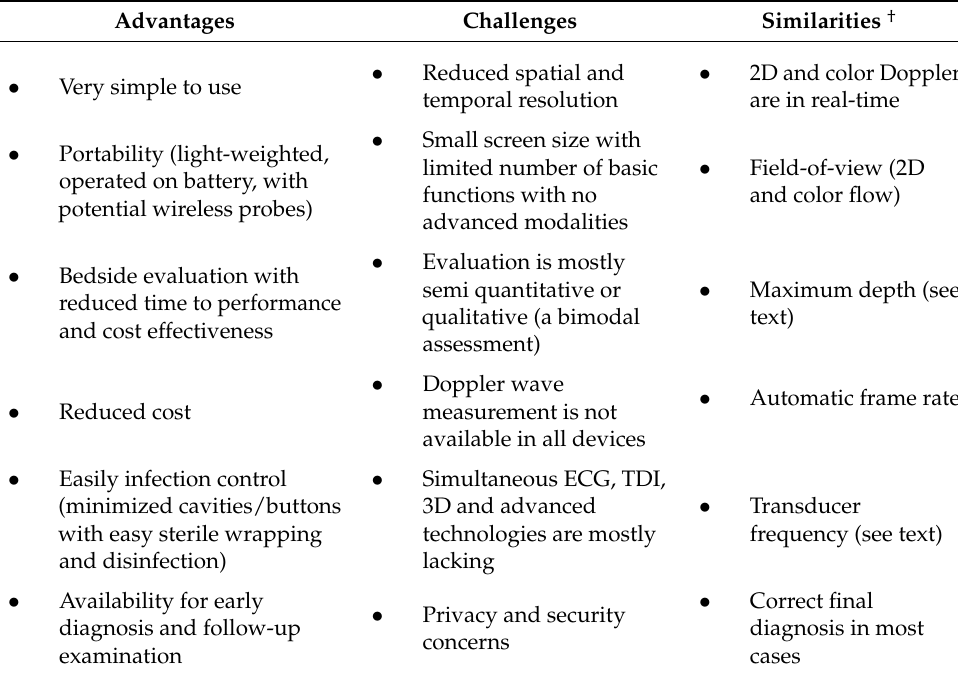
Table 1. Advantaged and challenges * in HUD utilization for echocardiographic assessment in COVID-19 setting as compared with conventional